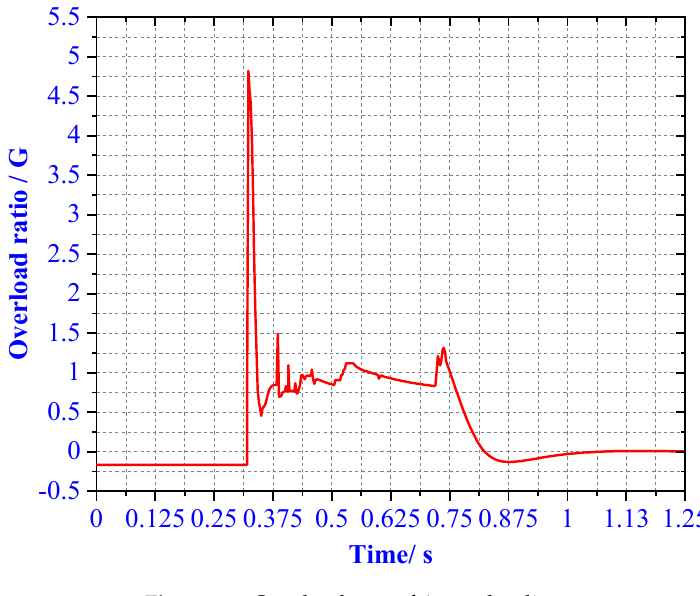
Figure 17. Overload rate of 4 type landing.